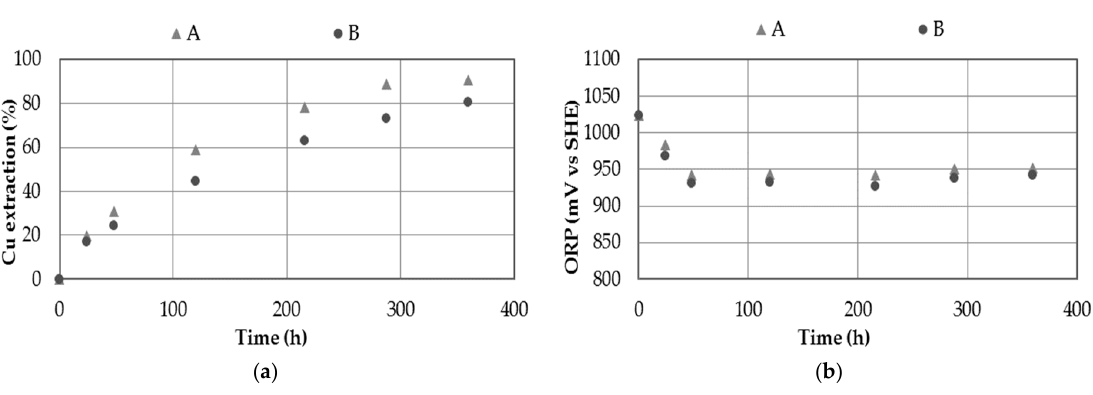
Figure 12. a) Copper extraction (%) versus time (h) when different concentrate samples were used: 326 Figure 12. ( a ) Copper extraction (%) vs. time (h) when di ff erent concentrate samples were used: A and B. b) Redox potential (mV) versus time (h) when different concentrate samples were used: A 327 A and B. ( b ) Redox potential (mV) vs. time (h) when di ff erent concentrate samples were used: A and B. and B. Experimental conditions: [NaNO 3 ] = [H 2 SO 4 ] = 0.7 M, 45 °C and seawater as dissolvent. 328 Experimental conditions: [NaNO 3 ] = [H 2 SO 4 ] = 0.7 M, 45 ◦ C and seawater as